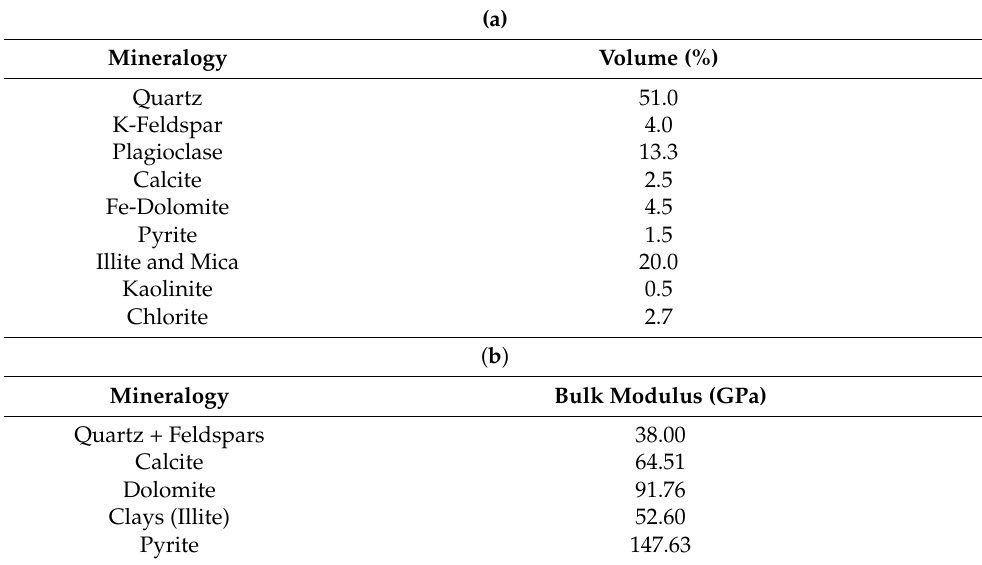
Table 1. (a) Composition from XRD of the core sample. (b) Constituent mineral bulk modulus used in determining matrix